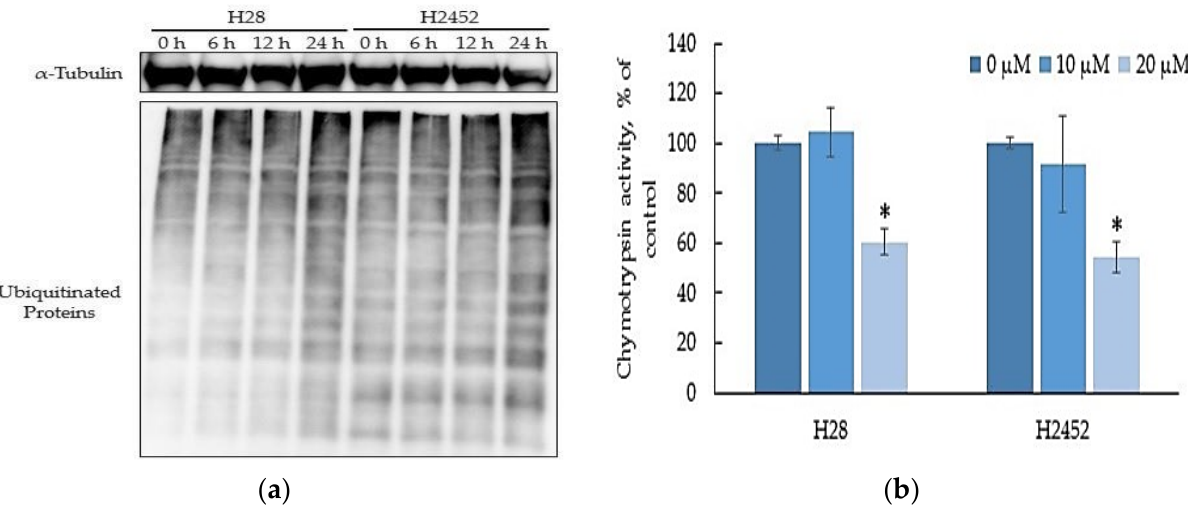
Figure 2. Effects of α -T3E on proteasome activities in H2452 cells and H28 cells. ( a ) Cells were treated with 20 µM α -T3E for 0, 6, 12, or 24 h. After the treatment, the ubiquitinated protein levels in the samples were assessed by immunoblotting as described in Section 4.7. The α -Tubulin protein levels served as the loading control. The results are representative of two independent experiments. ( b ) After cells were treated with α -T3E (10–20 µ M) for 24 h, chymotrypsin-like activity was assessed by a chemiluminescent method as described in Section 4.5. The data are means ± SD, n = 3. * p < 0.05 vs. the